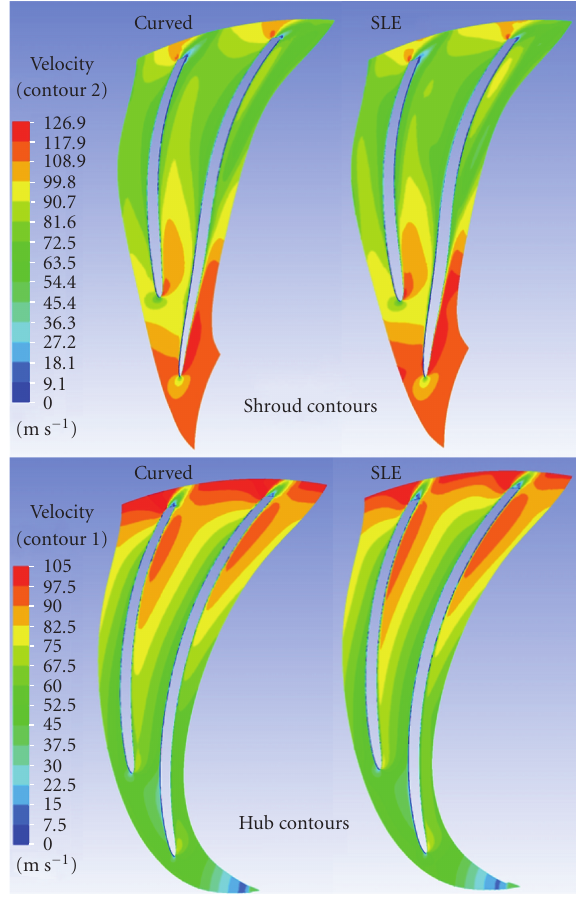
Figure 7: Relative velocity contours along the hub and shroud of the impeller at flow factor of 0.0713.